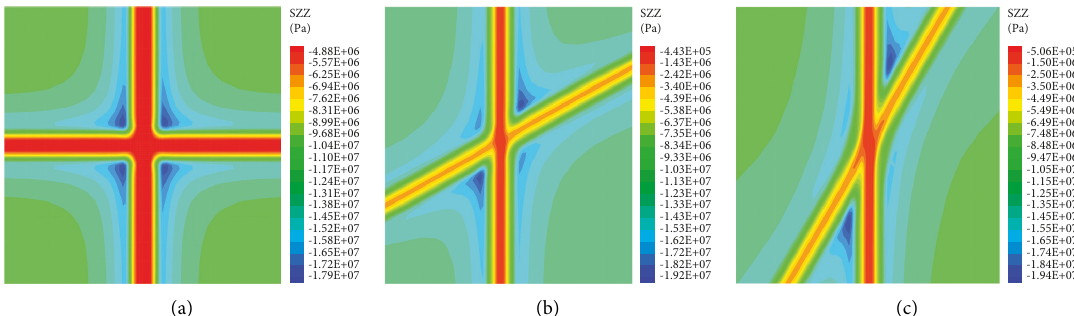
Figure 6: Disturbance influence of horizontal azimuth angle on surrounding rock vertical stress of staggered roadways. (a) 90 ° horizontal azimuth angle of staggered roadways, (b) 60 ° horizontal azimuth angle of staggered roadways, and (c) 30 ° horizontal azimuth angle of staggered roadways.